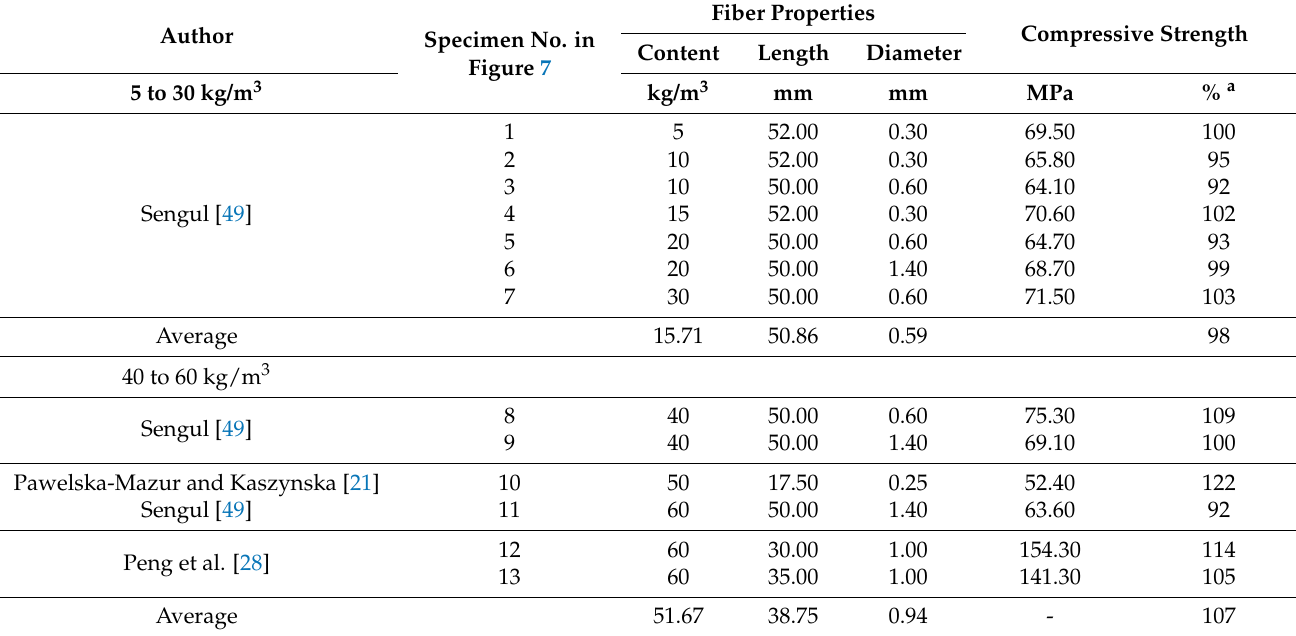
Table 5. Results of compressive strength’s percent comparison and fiber properties of the concrete with RSF in kg/m 3